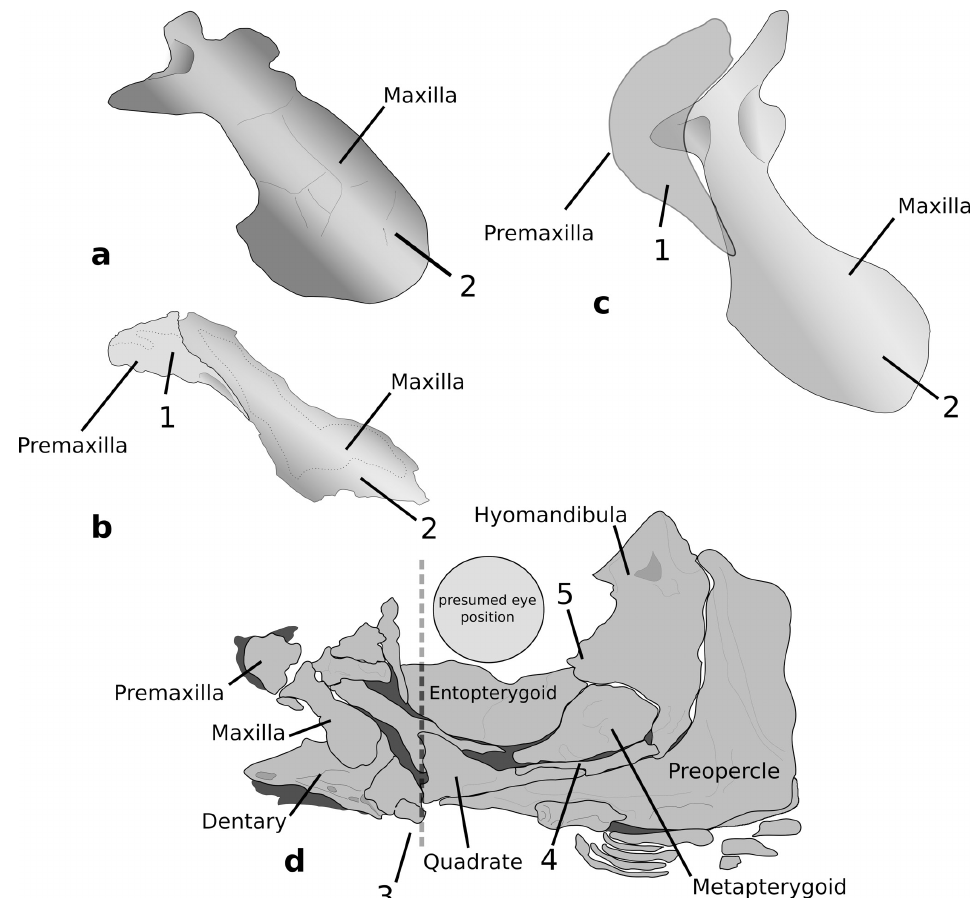
Fig. 6 . a . Maxilla of Dastilbe moraesi (CPUFMT 734), lateral view, anterior to left; b . Maxilla and premaxilla of Dastilbe crandalli, uncatalogued specimen, lateral view, anterior to left; c . Maxilla and premaxilla of Chanos chanos , ANSP 63199, lateral view, anterior to left. d . Jaws and suspensorium of Dastilbe moraesi (CPUFMT 730, 30.0 mm TFL), lateral view, anterior to left. Synapomorphies of Chanoidei observed are: 1-Large, very broad, concave-convex premaxilla, with long oral process; 2- posterior region of the maxilla expanded in a bulbous outline; 3- quadrate-mandibular articulation anteriorly displaced, anterior to orbit; 4- symplectic elongated; 5- metapterygoid process of hyomandibula present on its anterior